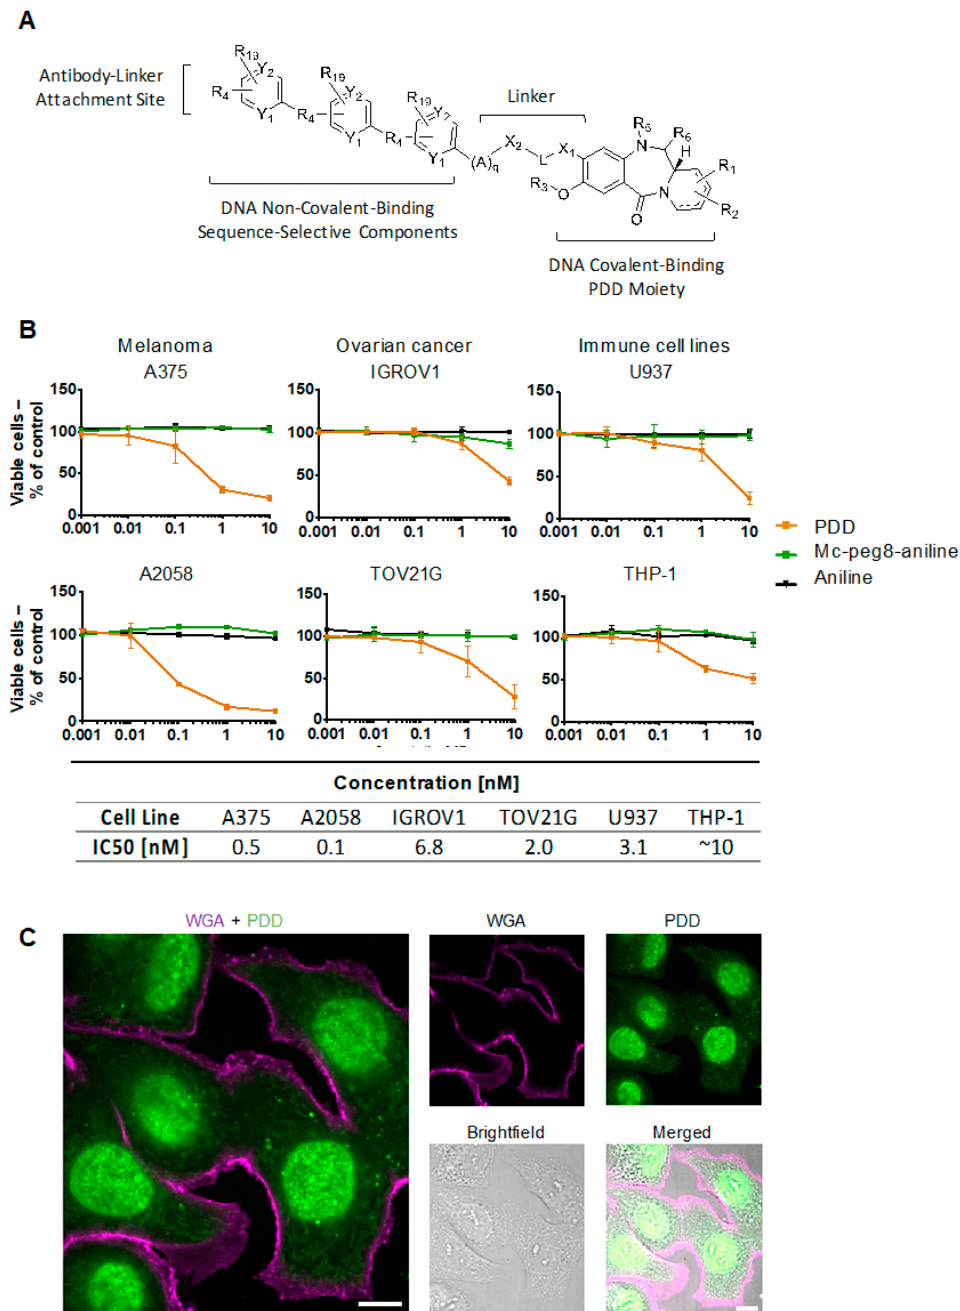
Figure 3. Structure, cytotoxicity profile and localization of the novel payload PDD. ( A ) Schematic of the PDD-based payload consisting of an antibody-linker attachment site, DNA non-covalent-binding sequence-selective components, linker and DNA covalent-binding PDD moiety; ( B ) Investigation of the cytotoxicity of the PDD in melanoma (A375, A2058), ovarian (IGROV1, TOV21G) and immune (U937, THP-1) cell lines. Cell viability was measured upon treatment with the PDD, a dummy payload (aniline) and the linked dummy payload mc-peg8-aniline; IC 50 values are shown for each cell line below; ( C ) Investigation of PDD intracellular localization in SKBR-3 cells after 3 hours of incubation by confocal microscopy (scale bar: 10 μ m), 100 × magnification.